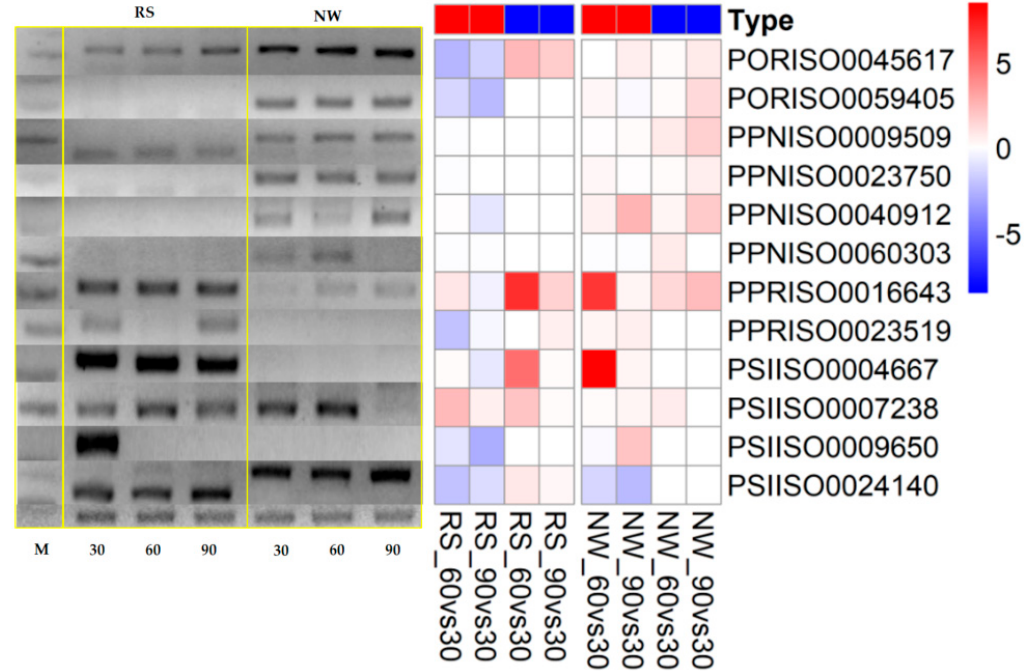
Figure 8. qRT ‐ PCR validation of twelve transcripts. The M is the marker and the color code for the type is RNA ‐ Seq (Red) and qRT ‐ PCR (Blue) respectively. In the heat ‐ map the relative expression of qRT ‐ PCR and log 2 FC values were compared to assesses the similar expression. Here, the 16s rRNA is used as a house keeping in qRT ‐ PCR experiment (bottom row of the gel ‐ image).